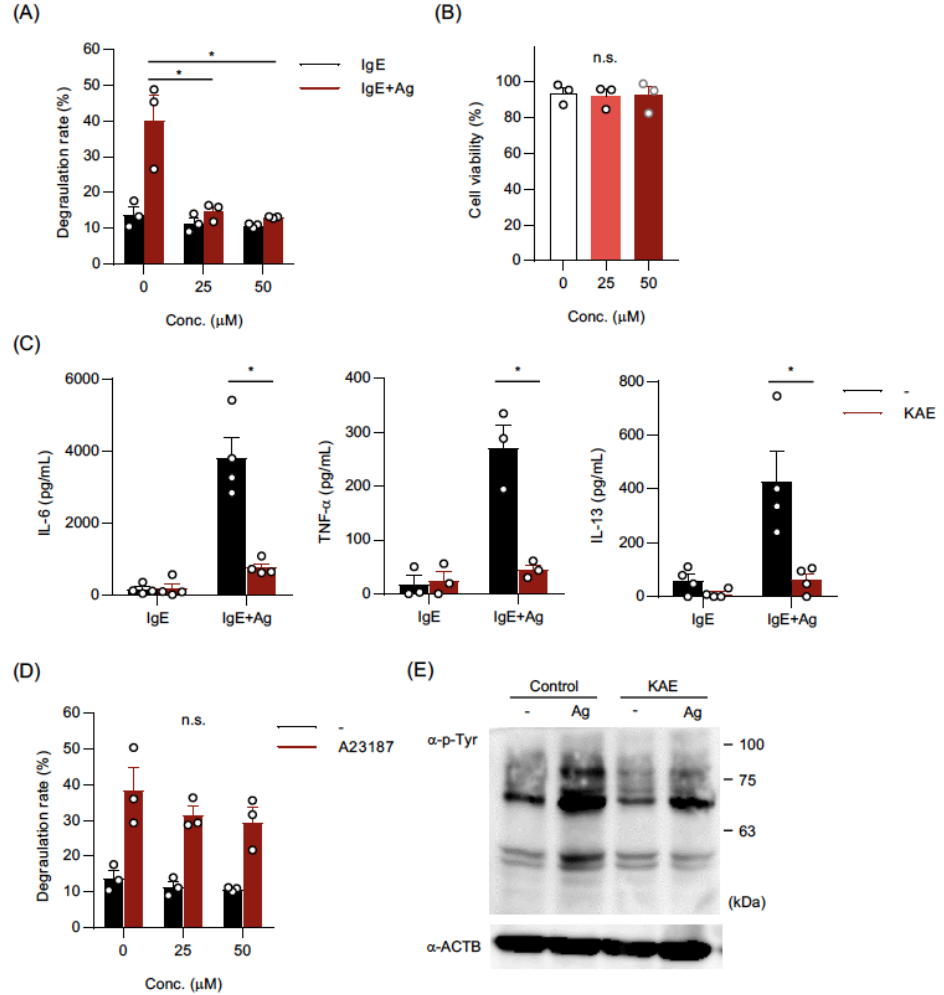
Figure 1. Kaempferol suppressed IgE-mediated activation of BMMCs. BMMCs were pre-incubated in the presence or absence of kaempferol (KAE) (50 µ M or indicated concentrations) for 24 h followed by each assay. ( A ) Effects of KAE on the IgE-mediated degranulation of BMMCs. After sensitization with anti-TNP-IgE, BMMCs were incubated in Tyrode’s buffer with or without TNP-BSA, and the supernatant and cells were collected for β -hexosaminidase assay. ( B ) Effects of KAE on the viability of BMMCs. DAPI-stained cells were judged to be dead cells. ( C ) Inhibition of cytokine release from BMMCs by KAE. IgE-sensitized BMMCs were incubated in culture medium with or without TNP-BSA for 3 h and the supernatant was collected. ( D ) Effects of KAE on the degranulation of BMMCs induced by A23187. BMMCs were incubated in Tyrode’s buffer with or without A23187, and the supernatant and cells were collected for β-hexosaminidase assay. ( E ) Western blot analysis of tyrosine-phosphorylated proteins. BMMCs were stimulated with IgE plus TNP-BSA for 10 min. Whole cell lysate containing 10 µ g protein was added to each lane. The data shown in ( A – D ) represent the mean ± SEM of 3~4 independent experiments, respectively. The data shown in ( E ) represents a typical data of three other independent experiments. Dunnett’s multiple comparison test ( A , D ) and two-tailed paired t-test ( C ) were used for statistical analyses. *, p < 0.05; n.s., not significant. Abbreviation: Conc., concentration; Ag, Antigen; KAE, Kaempferol.